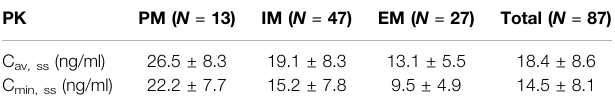
TABLE 4 | Summary statistics for the C ss of different type of metabolizers of escitalopram. PK